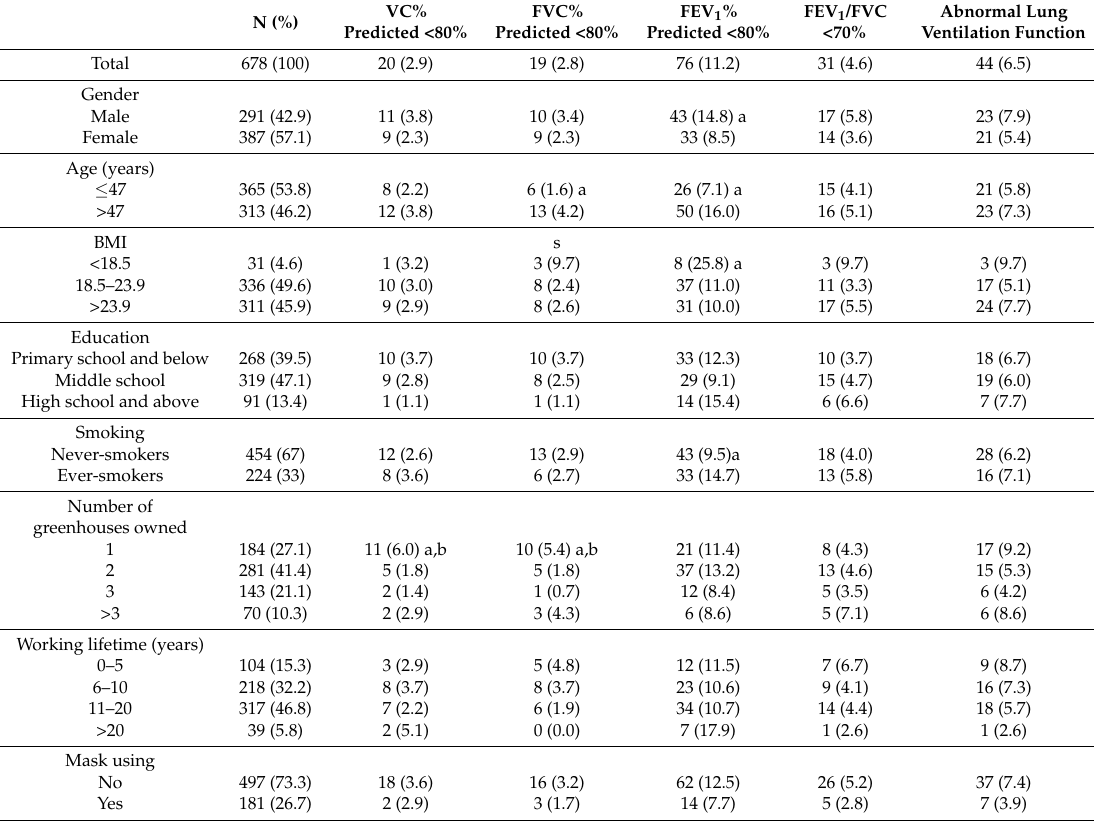
Table 2. Positive rates of abnormal lung ventilation function among greenhouse workers.